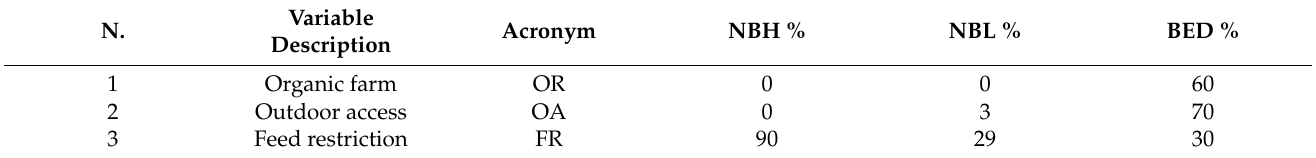
Table 5. Descriptive statistics for 3 dichotomous variables; percentage of farms in the